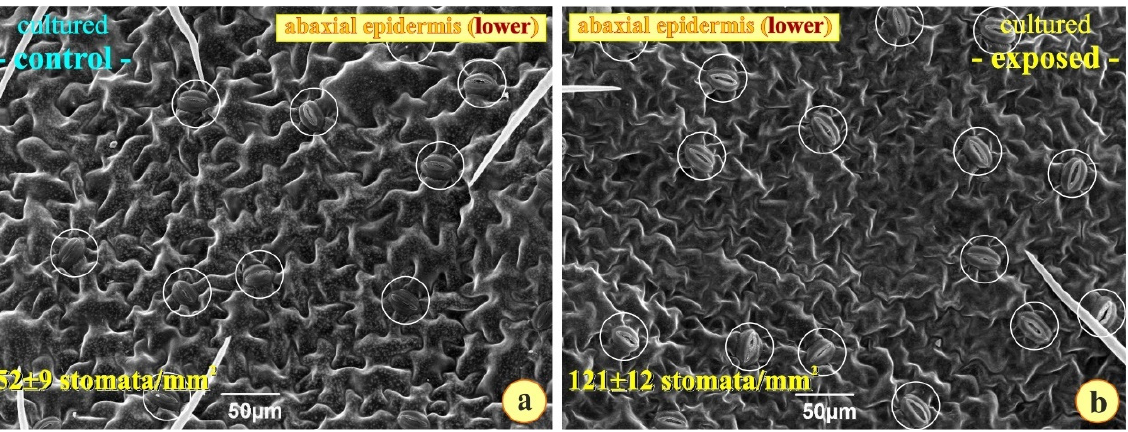
Figure 9. ( a ) Detail of the lower epidermis of a “control” plant. Each stoma is traced by a circle around it. ( b ) Detail from the lower epidermis of an “exposed” plant. The stomata can easily be observed. (All scale bars are 50 μ m)